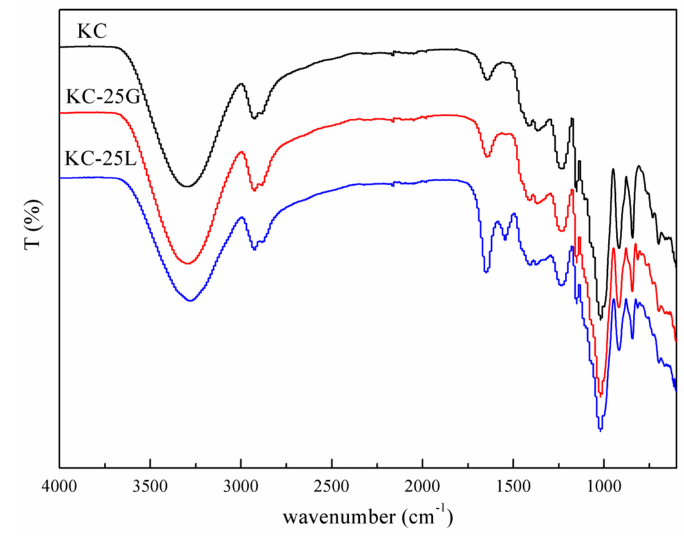
Figure 3. FTIR spectra of KC, KC-25G and KC-25L.